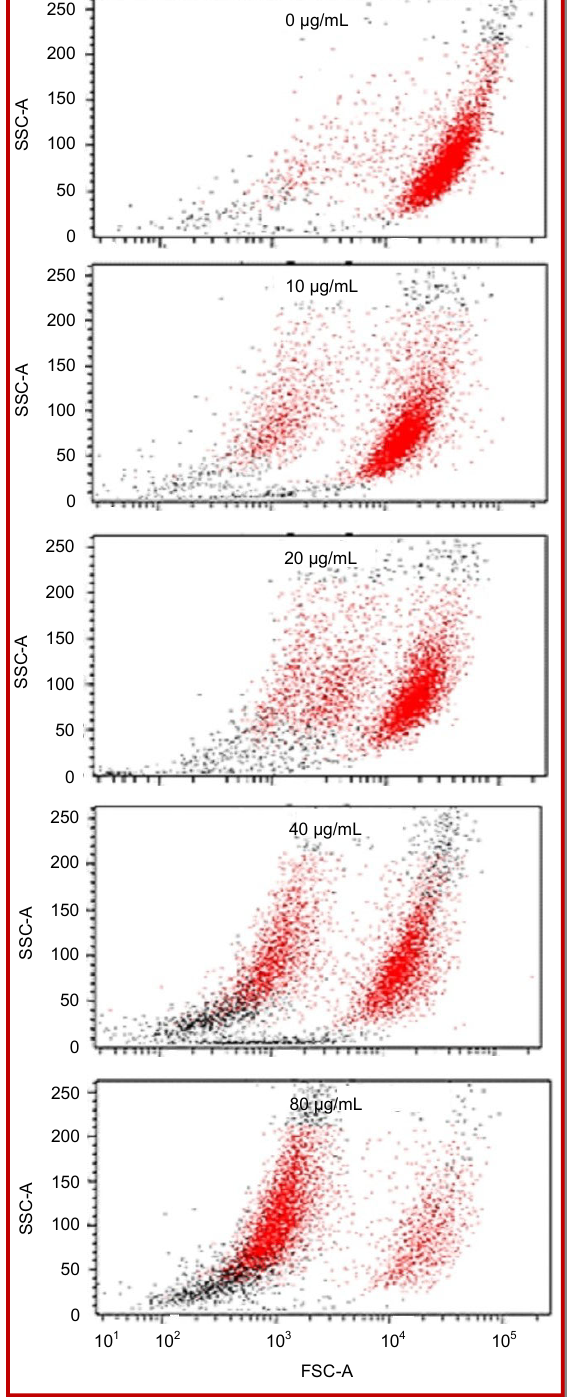
Figure 1: Effect of methanol extract of of P. macrophyla on dot- blot light scattering profile of Colo-205 cancer cells. Treatment of Colo-205 cells with different concentration of extract (0-80 μ g/mL) significantly increased the side-scattering (SSC) pro- file due to increased cellular granularity because of chromatin fragmentation and significant decrease in forward-scattering (FSC) profile due to shrinkage of